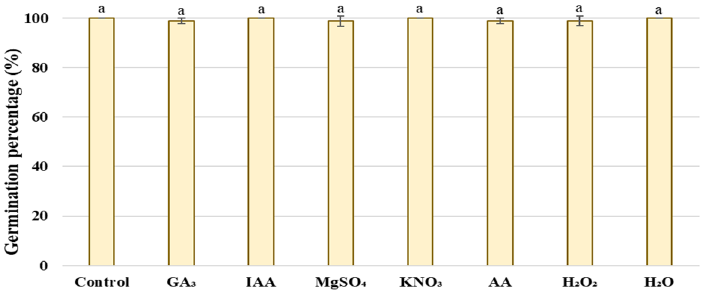
Figure 2. Effect of different priming treatments on germination percentage (GP) (%) of wheat. Same letters above bars indicates that differences were not significant ( p > 0.05) using Tukey test.